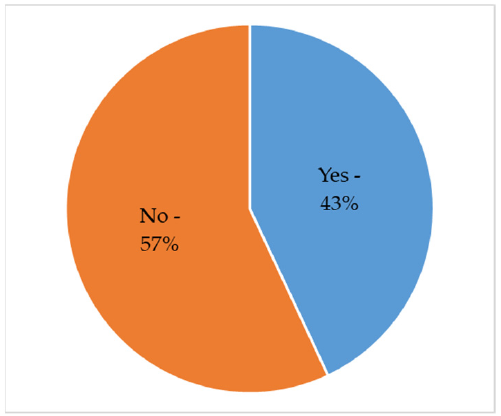
Figure 8. Selected survey results—an analytical–political perspective: are there changes currently planned in the strategic documents of the province's development that would lead to the implemen- tation of the European Green Deal?